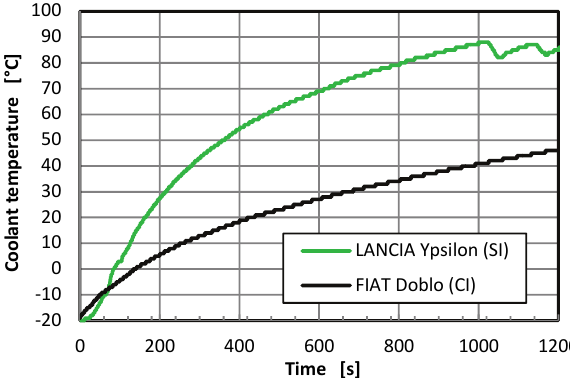
Fig. 9. The coolant temperature at the ambient temperature –18°C